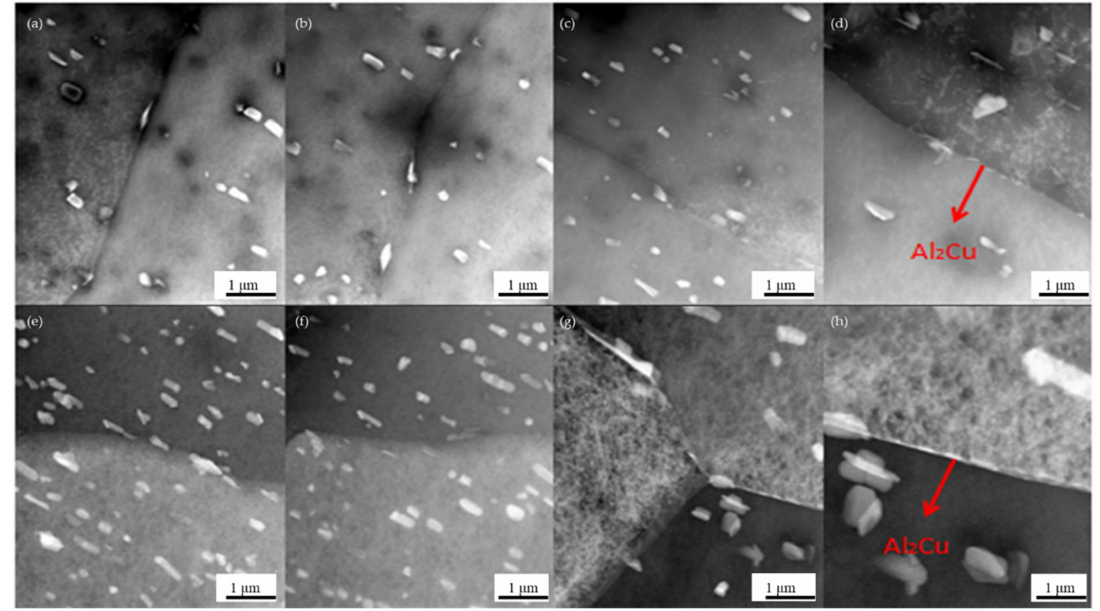
Figure 3. ( a – h ) The TEM images of 2024 alloy in the matrix and along the grain boundary.